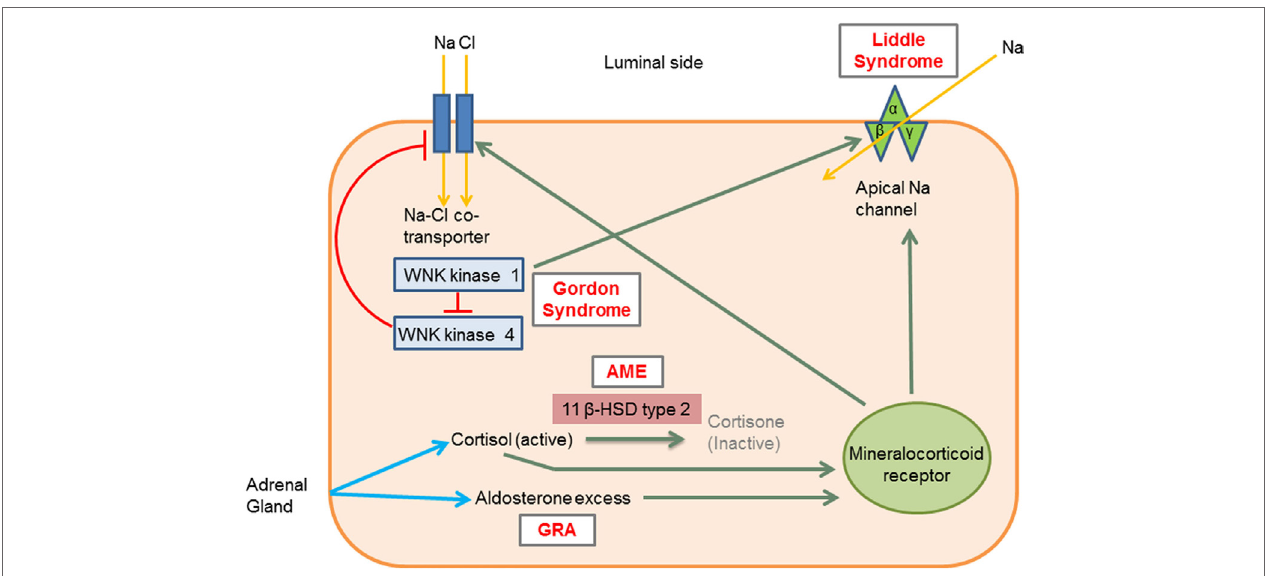
FiGURe 1 | Molecular mechanisms involved in the different types of monogenic hypertension (HTN). Liddle syndrome: gain-of-function mutation in the gene encoding the apical epithelial sodium channel (ENaC) causes increased sodium absorption and subsequent HTN. Gordon syndrome: WNK1 normally inhibits WNK4, which in turn inhibits the Na–Cl cotransporter (NCC). WNK1 gain-of-function and WNK4 loss-of-function mutation increases the activity of the NCC leading to increased salt and water retention. AME: 11 β -hydroxysteroid dehydrogenase type II enzyme deficiency results in reduced cortisol conversion to cortisone (inactive form). Cortisol binds to the mineralocorticoid receptor and leads to signs of mineralocorticoid excess. GRA: a chimeric gene leads to excess aldosterone production, which acts on mineralocorticoid receptors. 11 β HSD type II, 11 β -hydroxysteroid dehydrogenase type II enzyme; AME, apparent mineralocorticoid excess; GRA, glucocorticoid-remediable aldosteronism; Activation, green arrows; Inhibition, red lines with barheads. [Adapted from Simonetti et al.